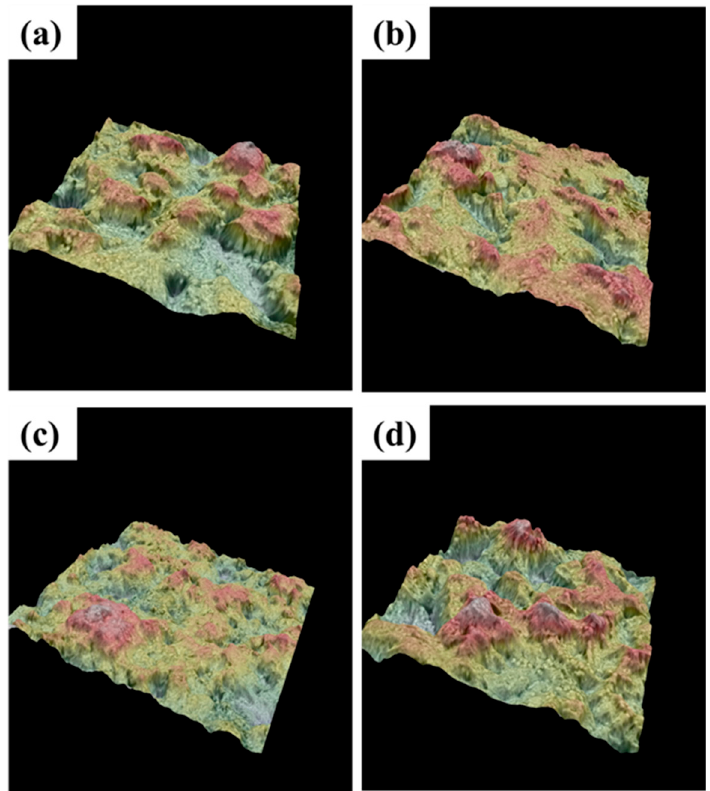
Figure 3. The 3D-imaging surface (depicted with heat map) for the prepared Ti/SnO 2 -Sb 2 O x -TiO 2 samples electrodeposited with different additions of TiO 2 sol: ( a ) 0 mL/L, ( b ) 5 mL/L, ( c ) 10 mL/L, ( d ) 15 mL/L.